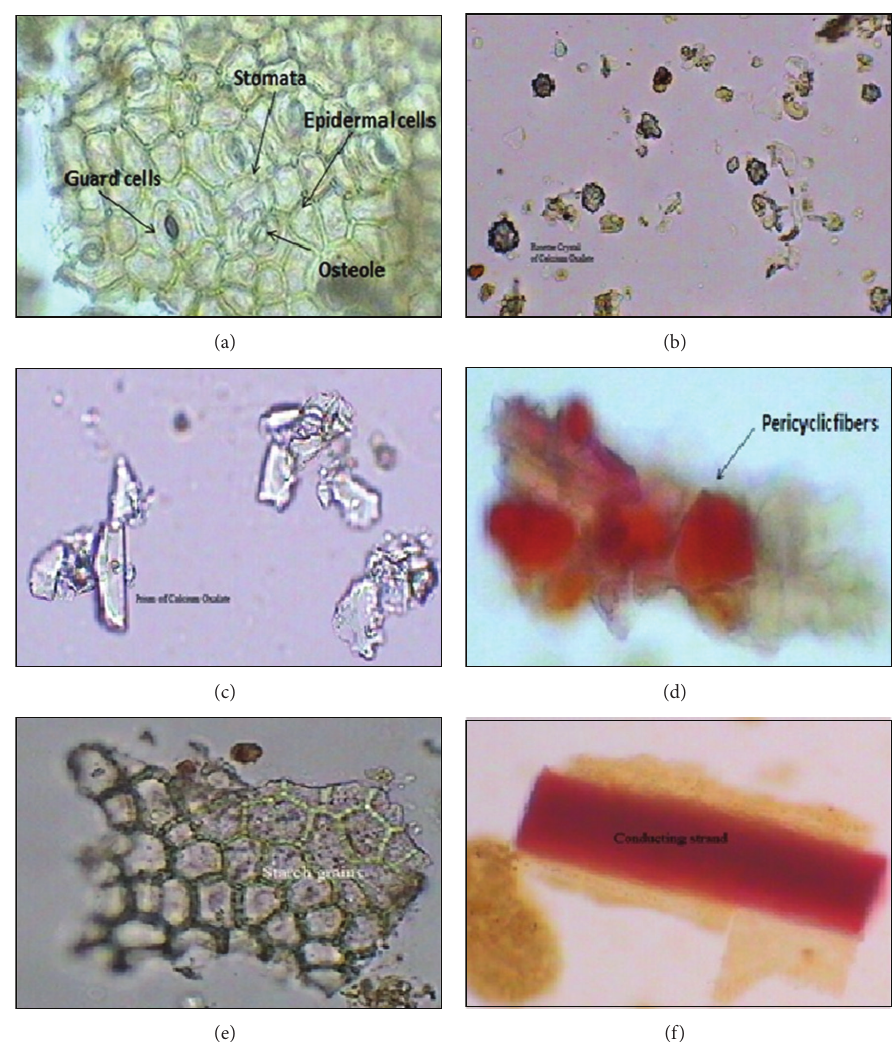
Figure 10: (a) Anomocytic stomata with guard cell. (b) Rosette calcium oxalate crystals and aleurone grains. (c) Prisms of calcium oxalate crystals. (d) Pericyclic fibers. (e) Epidermis and starch grains (45x). (f) Conducting strand (xylem) and brownish